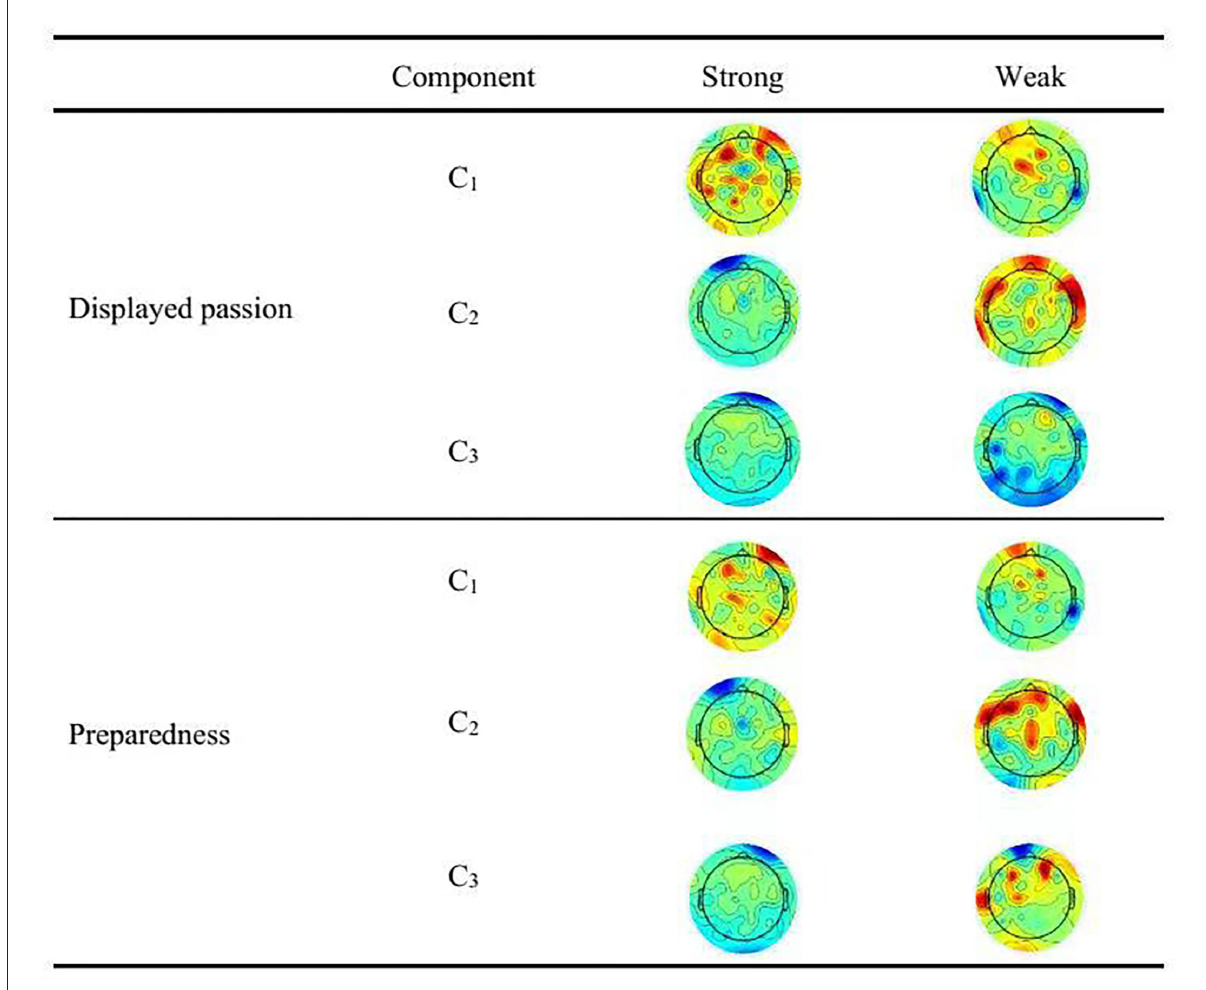
FIGURE3 Sensor contribution. Topographical map visualizes the strength that each sensor contributes to the correlated component. Each column represents the forward model (con-elation between surface electrodes and component activity) obtained using either all stimuli together (combining responses across all participants). The maps reveal the contribution by showing interpolated magnitudes of the scalp projections, that is the forward models of the maximally correlated components C 1 to C 3